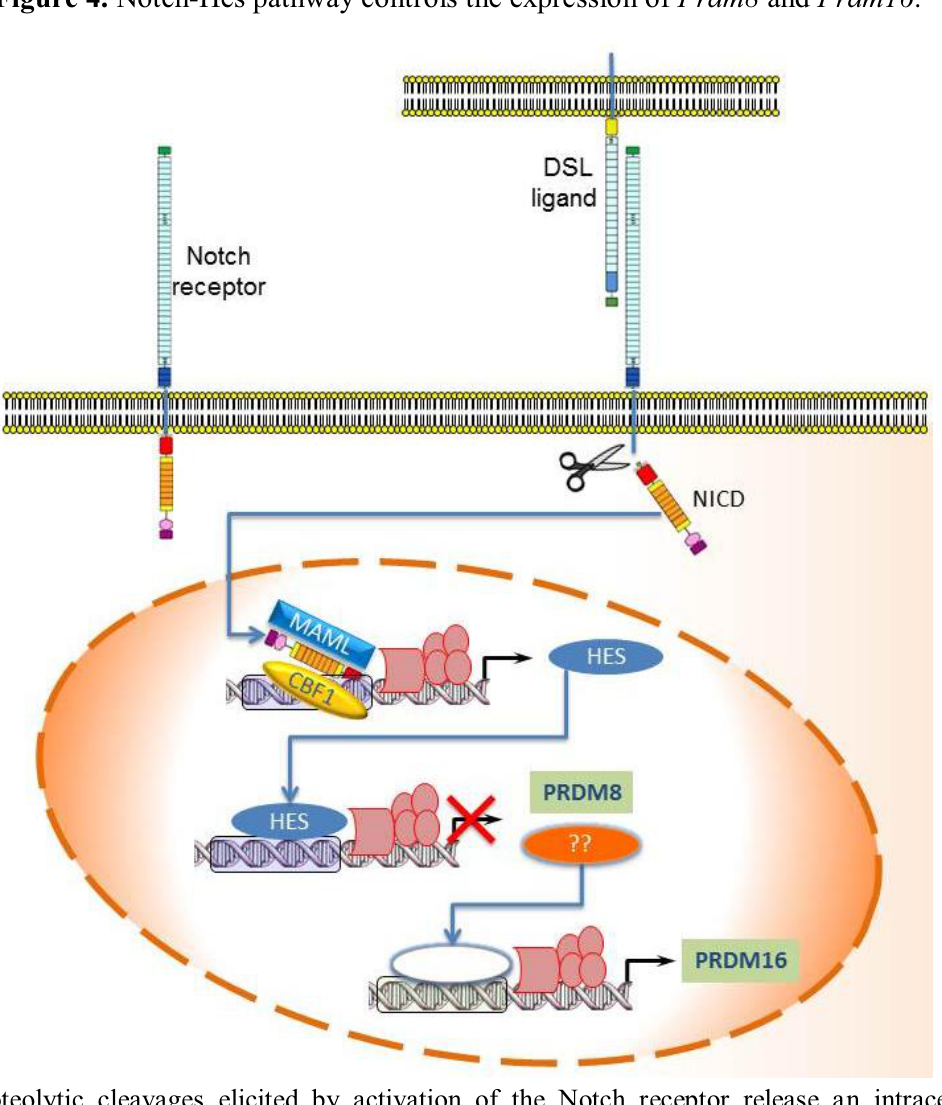
Figure 4. Notch-Hes pathway controls the expression of Prdm8 and Prdm16